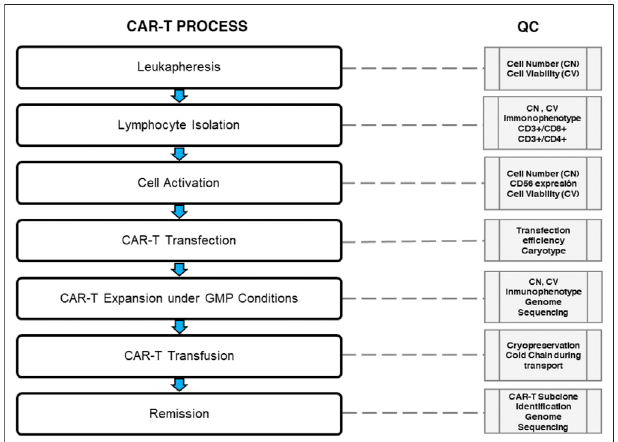
FIGURE 4 | Quality control during CAR-T cell therapy. The median of total nucleated cells (TNC) is 98 × 10 8 (range 9 - 341 × 10 8 ) with a viability analysis of 98% for quality control (QC) in the leukapheresis products. However, the QC could be set in 10 × 10 8 CD3 + T cells with a viability analysis of 98% (99.6 – 100%) in a median volume of 237 ml (136 – 310 ml) for CD3 + T cell isolation (Data based in the report of Korell et al., 2020). The normal transduction rate is around 20 – 60% using lentiviral vectors. A 2:1 ratio immunophenotype of CD4+: CAR-T (29 ± 18.1%) and CD8+: CAR-T (71 ± 18.1%) is recommended for clonal CAR-T cell expansion under GMP conditions. Clonal expansion must reach 3.1 × 10 6 transduced viable T cells per kilogram of body weight (range, 0.2 × 10 6 to 5.4 × 10 6 cells per kilogram); this CAR-T cells product is ready for cryopreservation. Cold chain must be controlled during transportation using liquid nitrogen. Prior infusion lymphodepleting chemotherapy with fl udarabine and cyclophosphamide it is used. Finally, rate a CAR-T subclone identi fi cation followed by genome sequency should be evaluated for measure the molecular